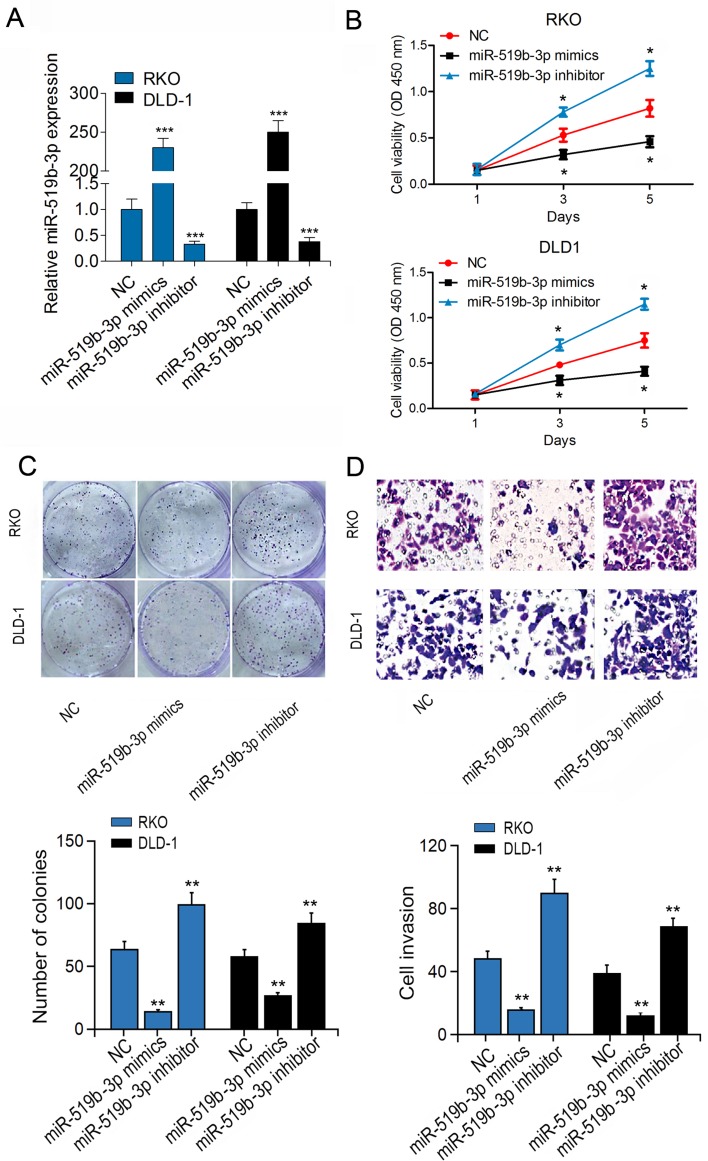
Overexpression of miR-519b-3p suppressed the proliferation and invasion of CRC cells. (A) Expression of miR-519b-3p in RKO and DLD-1 cells transfected with miR-519b-3p mimics or inhibitor was detected by qRT-PCR. (B) Cell proliferation was detected in RKO and DLD-1 cells transfected with miR-519b-3p mimics or inhibitor by cell counting kit-8 (CCK-8) assay. (C) The colony number was examined in RKO and DLD-1 cells. (D) The effect of miR-519b-3p on invasion was examined by Transwell assay. *p < 0.05, **p < 0.01, ***p < 0.001 vs. NC. NC, negative control.